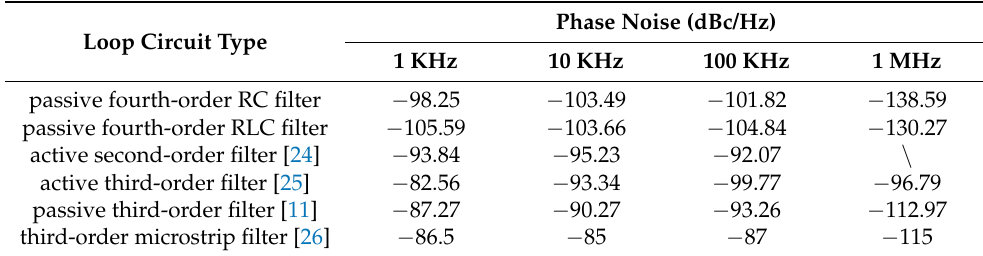
Figure 10. Output signal phase noise: ( a ) passive fourth-order RC filter and ( b ) passive fourth-order RLC filter. Table 6. Comparison of phase noises of different